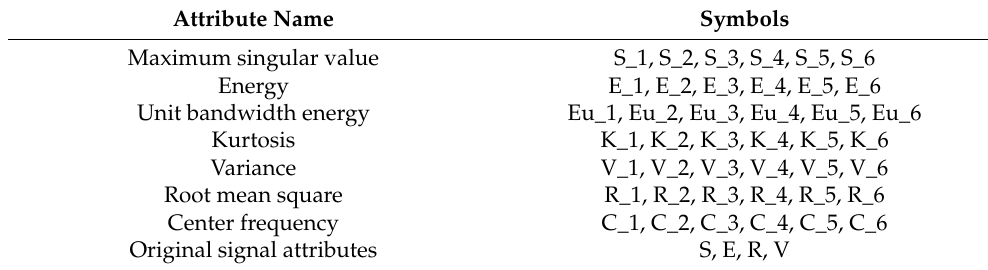
Table 5. Attribute names and